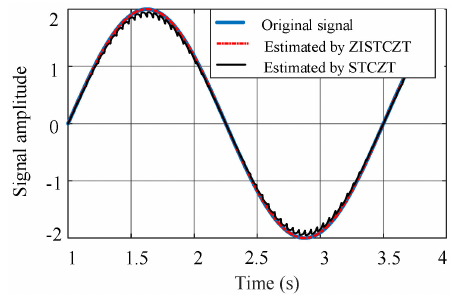
Figure 2. The STCZT and ZISTCZT result